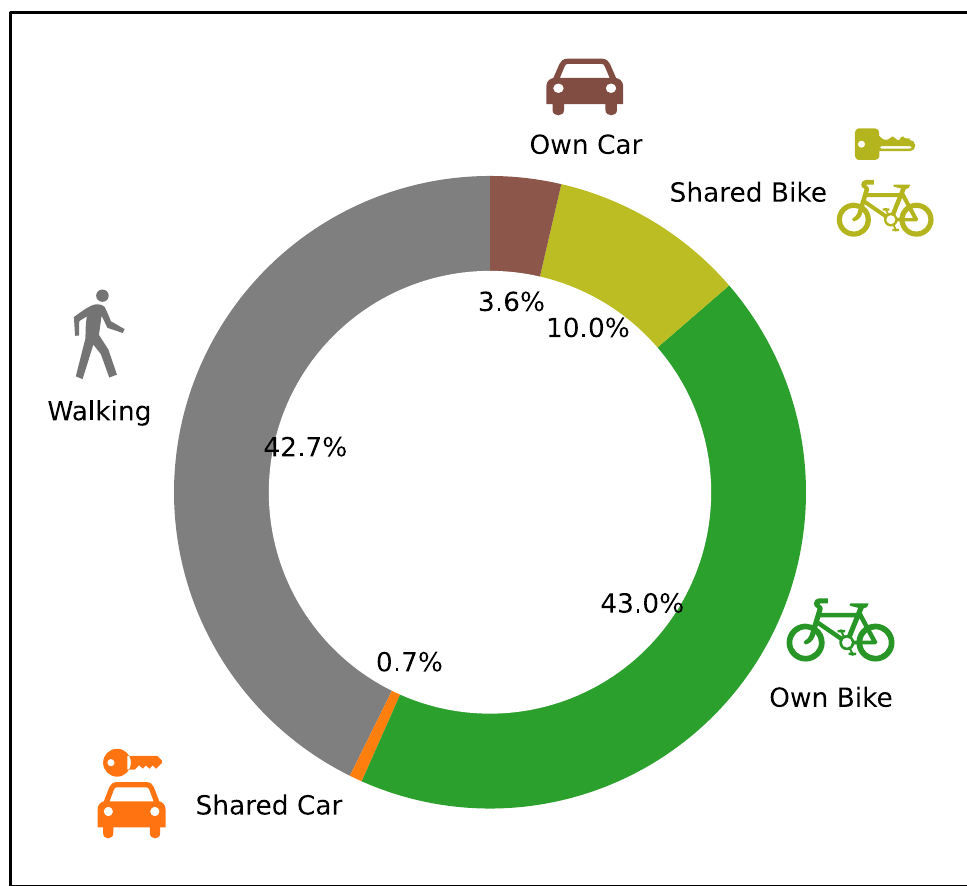
Figure 7. Average distribution of agents’ main modality in percent across simulation